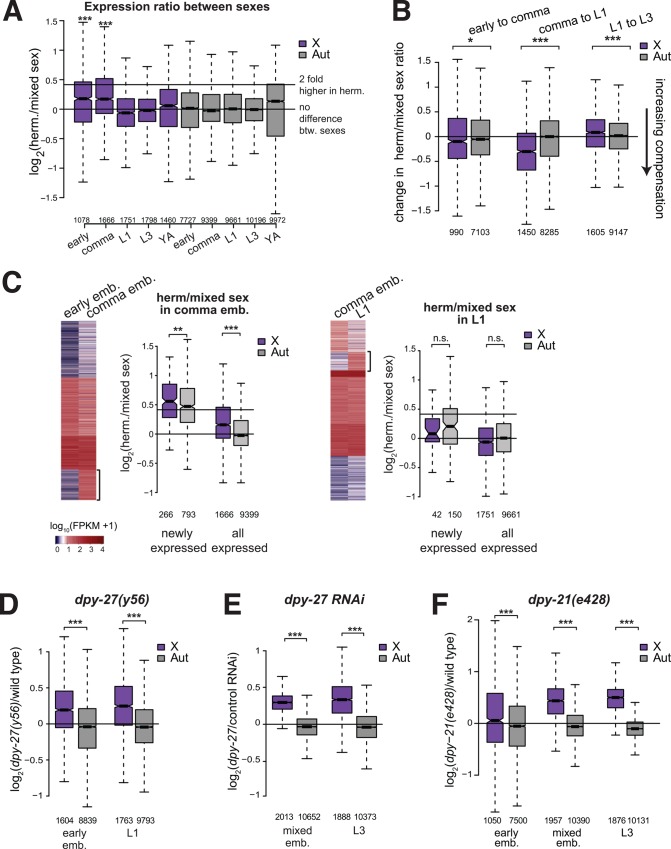
Majority of X chromosomal genes are dosage compensated after the comma stage of embryogenesis.(A) Boxplot shows the distribution of log2 fold-differences in mRNA levels between hermaphrodite and mixed sex worms for early embryos, comma stage embryos, L1 larvae, L3 larvae and young adults. Horizontal lines indicate ratio expected for equal and two-fold higher expression in hermaphrodites. Increased expression from the X was tested between X and autosomes by one-sided Wilcoxon rank-sum test (*** = p < 10−3). (B) Change in dosage compensation was calculated for each gene by subtracting log2(herm/mixed sex) at younger stage from the older stage. Difference in between X and autosome was tested by Wilcoxon rank-sum test (*** = p < 10−3, * = p < 0.05). (C) To identify newly expressed genes in comma embryos and L1 larvae, heat maps show K-means cluster analysis of expression levels in hermaphrodites between stages. Newly expressed genes in early embryos were identified as in Fig 2C. In comma embryos, hermaphrodite levels of newly expressed genes was significantly higher for X chromosomal genes compared to autosomal genes (one-sided Wilcoxon rank sum test, *** = p < 10−3, ** = p < 10−2, and * = p < 0.05.). In L1s, hermaphrodite to mixed sex ratio of expression was not significantly different between the X and autosomes, suggesting that these genes were mostly dosage compensated. (D) Boxplots show distribution of expression ratios on the X and autosomes between dpy-27(y56) mutant and wild type, and (E) between dpy-27 and control RNAi in the developmental stages listed below. X chromosome was significantly derepressed compared to autosomes in dpy-27(y56) mutant and dpy-27 RNAi at each developmental stage (one-sided Wilcoxon rank-sum test *** = p < 10−3). (F) Same as in (D) for the dpy-21(e428) mutant.